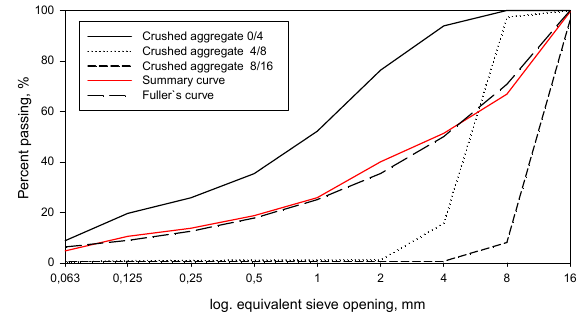
Figure 3. Cleaned recycled tire polymer fibers (RTPFc): a) picture of RTPFc; b) RTPFc with aggregates and filler.